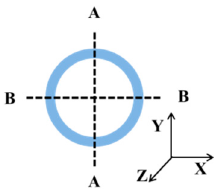
Figure 15. Illustration of the symmetric boundary conditions of stent.